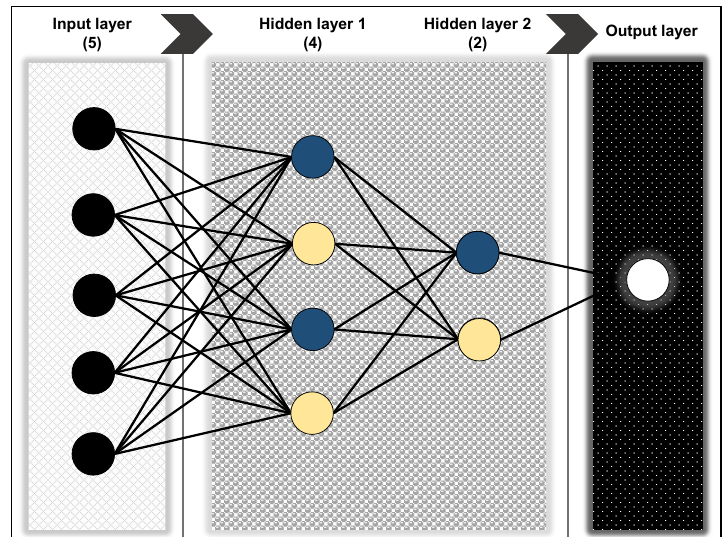
Figure 2. MLP network architecture.